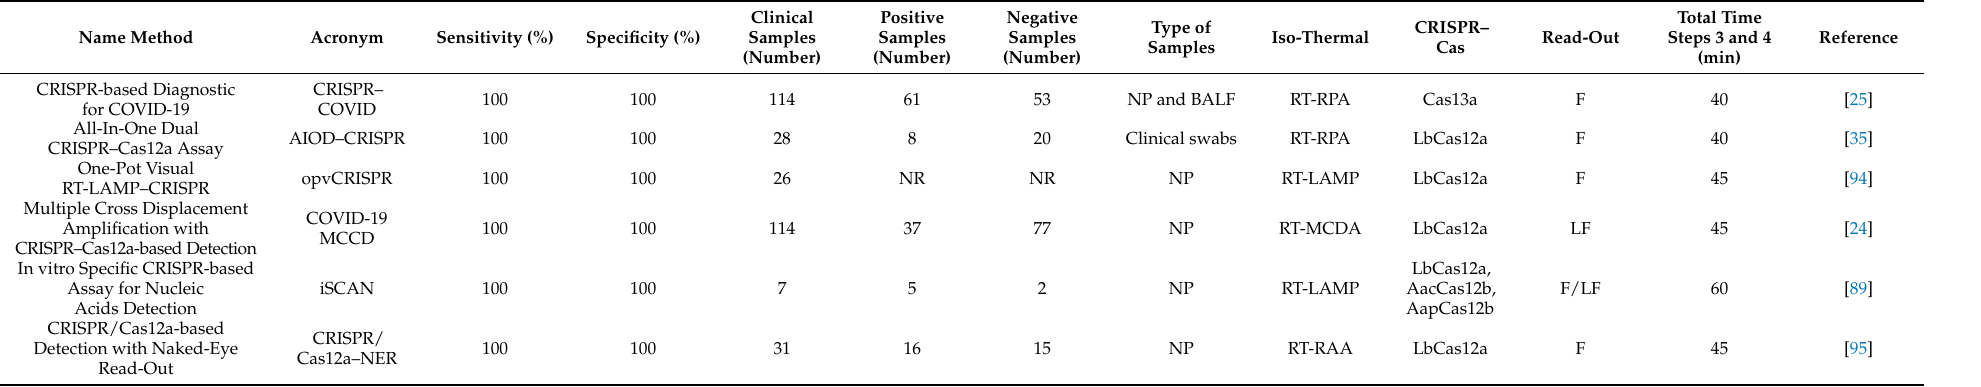
Table 5. List of CRISPR-based methods with highest clinical specificity and